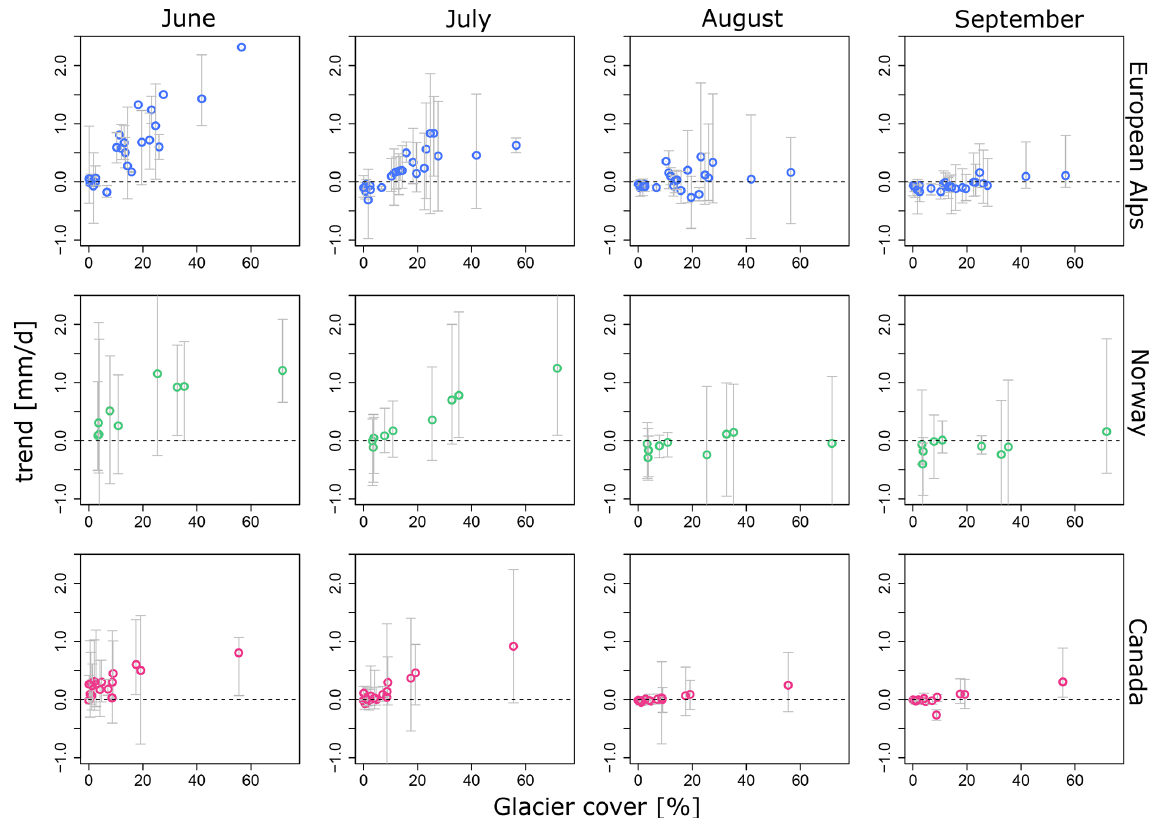
Figure 5. Trend of Q during the WD events in different regions (rows) and months (columns). The colored circles indicate the mean trend during the events per catchment, and the gray bars represent the whole